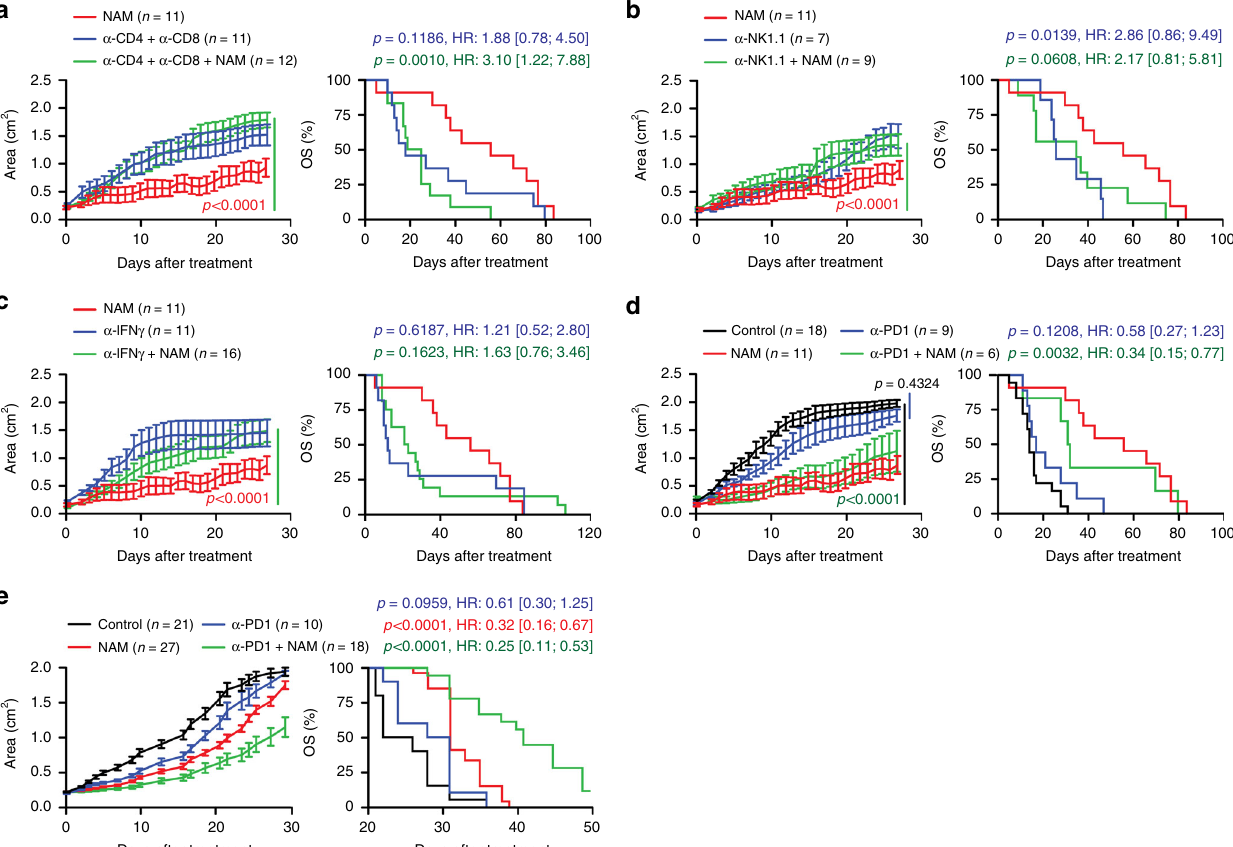
Fig. 7 The therapeutic effects of NAM depend on T cells and immune signaling. a – c Tumor growth and overall survival (OS) in C57BL/6 mice bearing established M/D-driven tumors that were maintained in control conditions ( a – c ) or subjected to NAM supplementation with the drinking water alone ( a – c ), or in the context of CD4 + and CD8 + T cell co-depletion ( a ), NK cell depletion ( b ), or IFNG neutralization ( c ). Tumor growth results are means ± SEM. Number of mice, hazard ratio (HR) and p values (two-way ANOVA corrected for row (time) and column (treatment) factors for tumor growth and two-sided log-rank for OS). Please note that NAM-treated tumors (red curves) in ( a – c ) are from the same experiment, also depicted in ( d ). d , e Tumor growth and OS in C57BL/6 ( d ) or BALB/c ( e ) mice bearing established M/D-driven ( d ) or TSA ( e ) tumors that were maintained in control conditions or subjected to NAM supplementation with the drinking water or systemic PD-1 blockage, alone or in combination. Tumor growth results are means ± SEM. Number of mice, hazard ratio (HR) and p values (two-way ANOVA corrected for row (time) and column (treatment) factors for tumor growth and two- sided log-rank for OS). Please note that NAM-treated tumors (red curves) in ( d ) are from the same experiment depicted in ( a – c